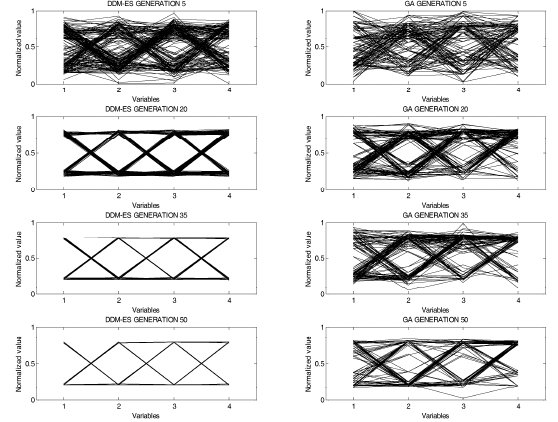
Fig. 7 Populations with function MGM with 4